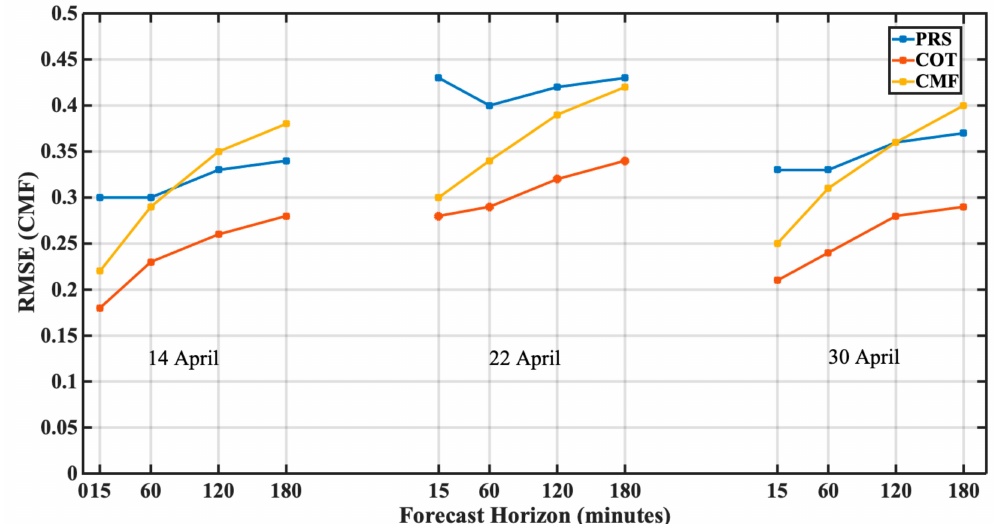
Figure 8. The cloudy sky to clear sky TRN forecasting error of CMF in terms of RMSE during the 3 case study days for the PRS, COT, and CMF short-term forecasting approaches for 15 min, 1, 2 and 3 h forecast horizon.